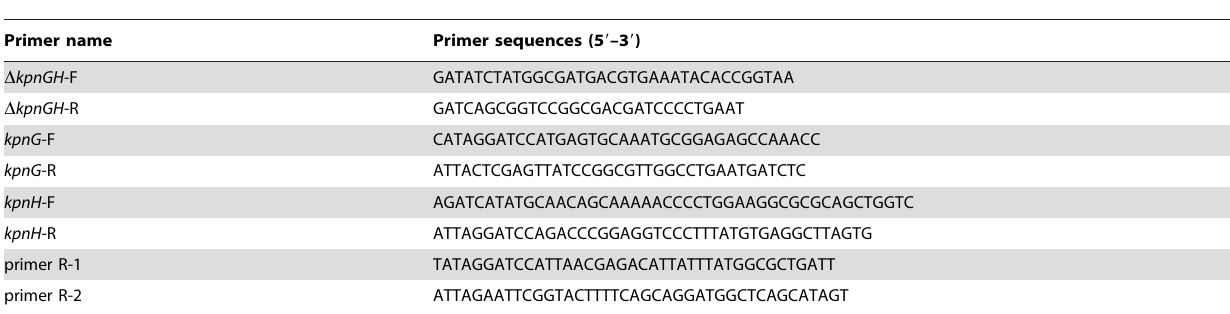
Table 1. Primers used in this